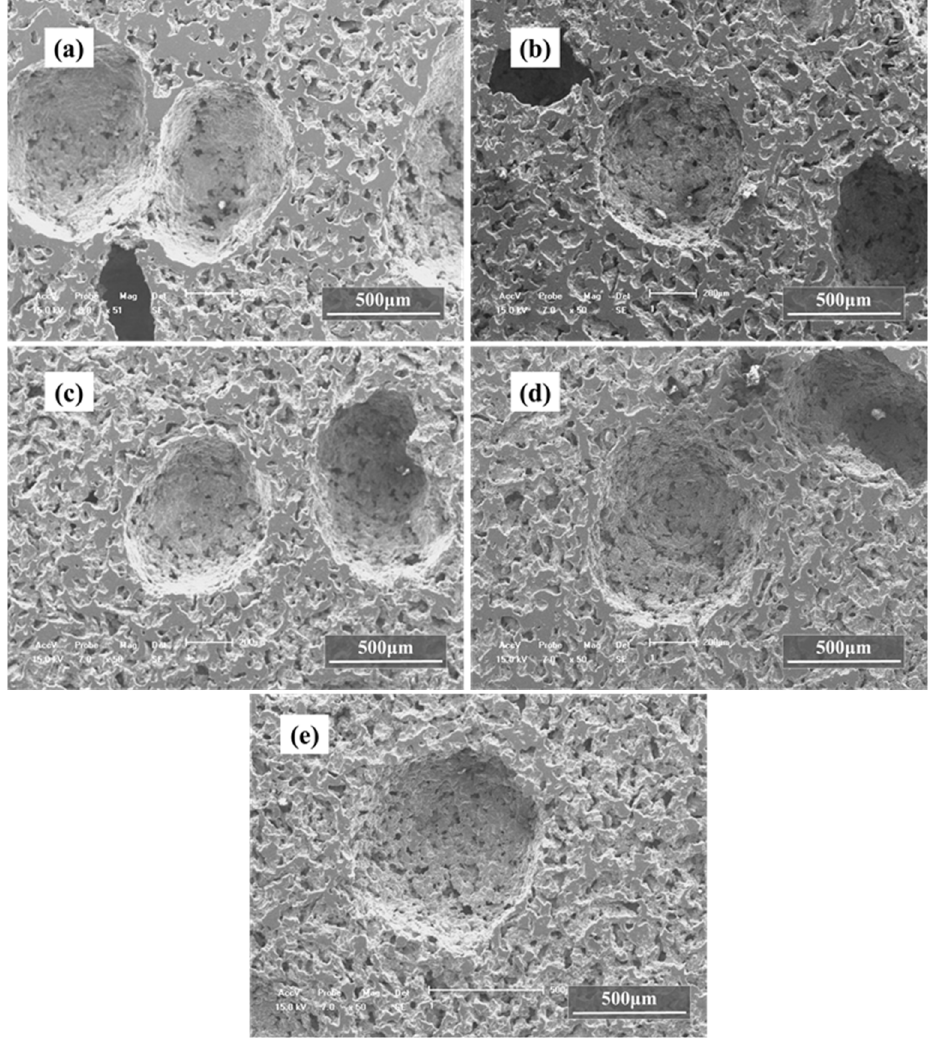
Figure 10. SEM images of porous titanium with 70 vol.% magnesium spacers after sintering, in which volume fractions of magnesium powders are 25% ( a ), 30% ( b ), 35% ( c ), 40% ( d ) and 45% ( e ).